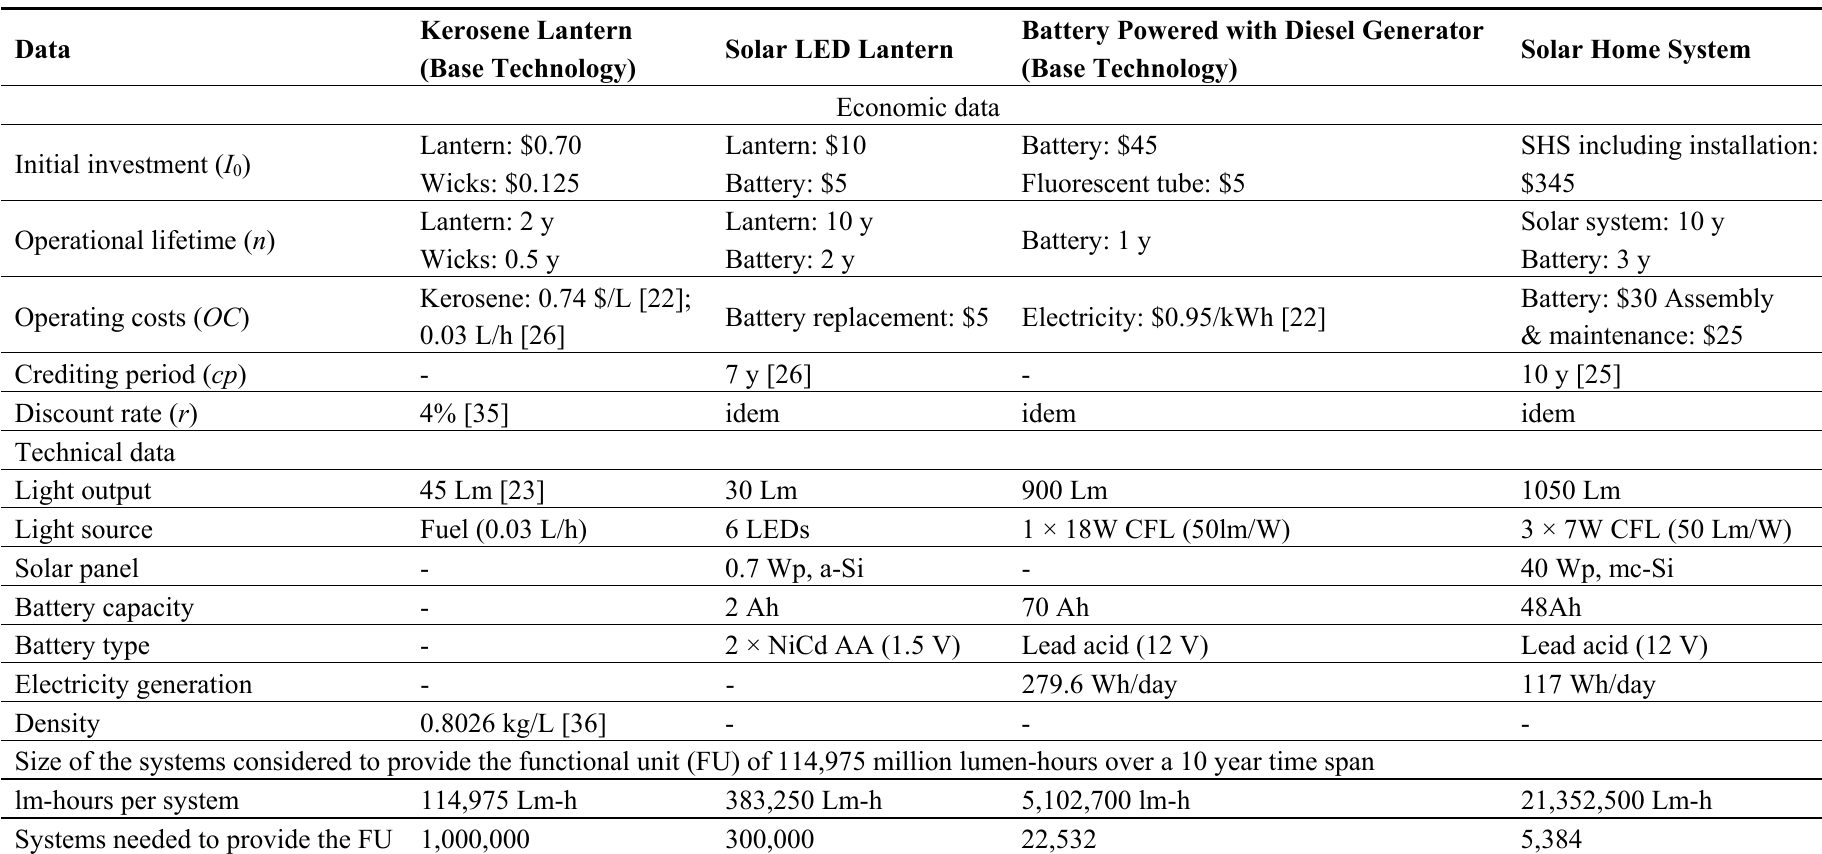
Table A1. Off-grid lighting technologies: Data provided by the Kamworks company (December